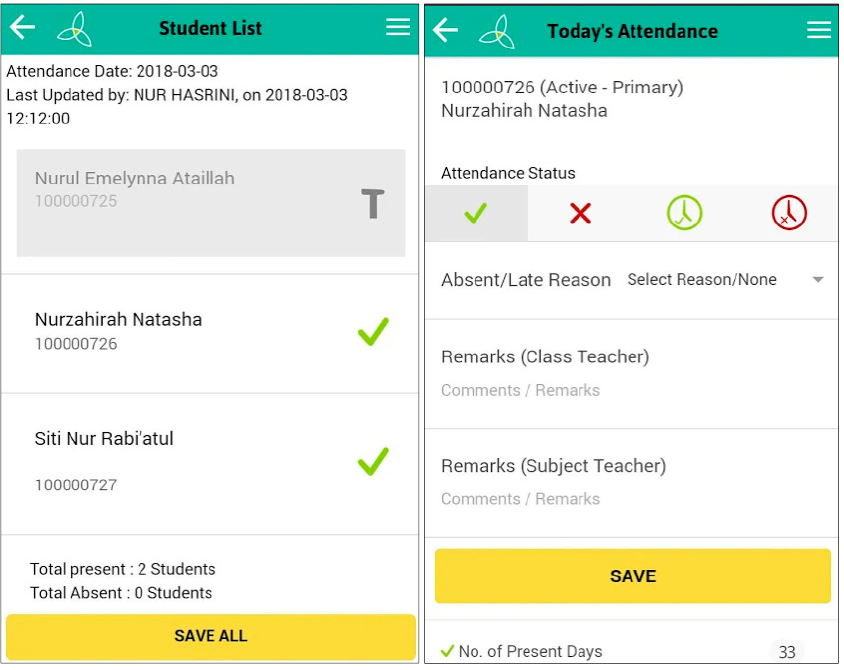
Figure 5. Digital education features.